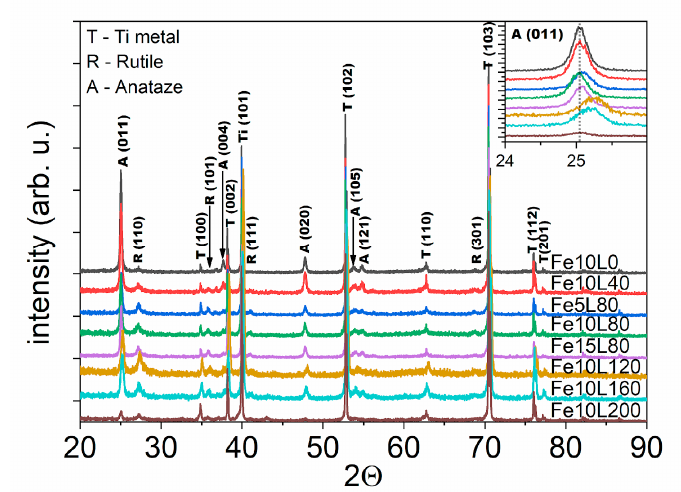
ff raction patterns of laser-annealed Fe-decorated TiO Figure 4. X-ray diffraction patterns of laser-annealed Fe-decorated TiO 2 -NTs. Figure 4. X-ray di